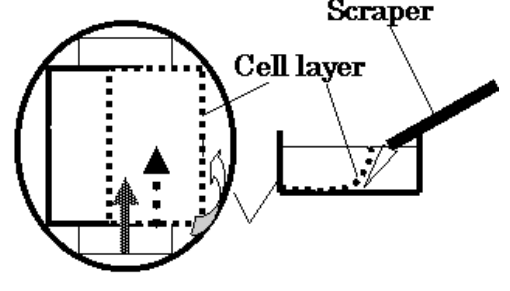
FIGURE 1. Cell-separation technique using a scraper. Arrows show directions of